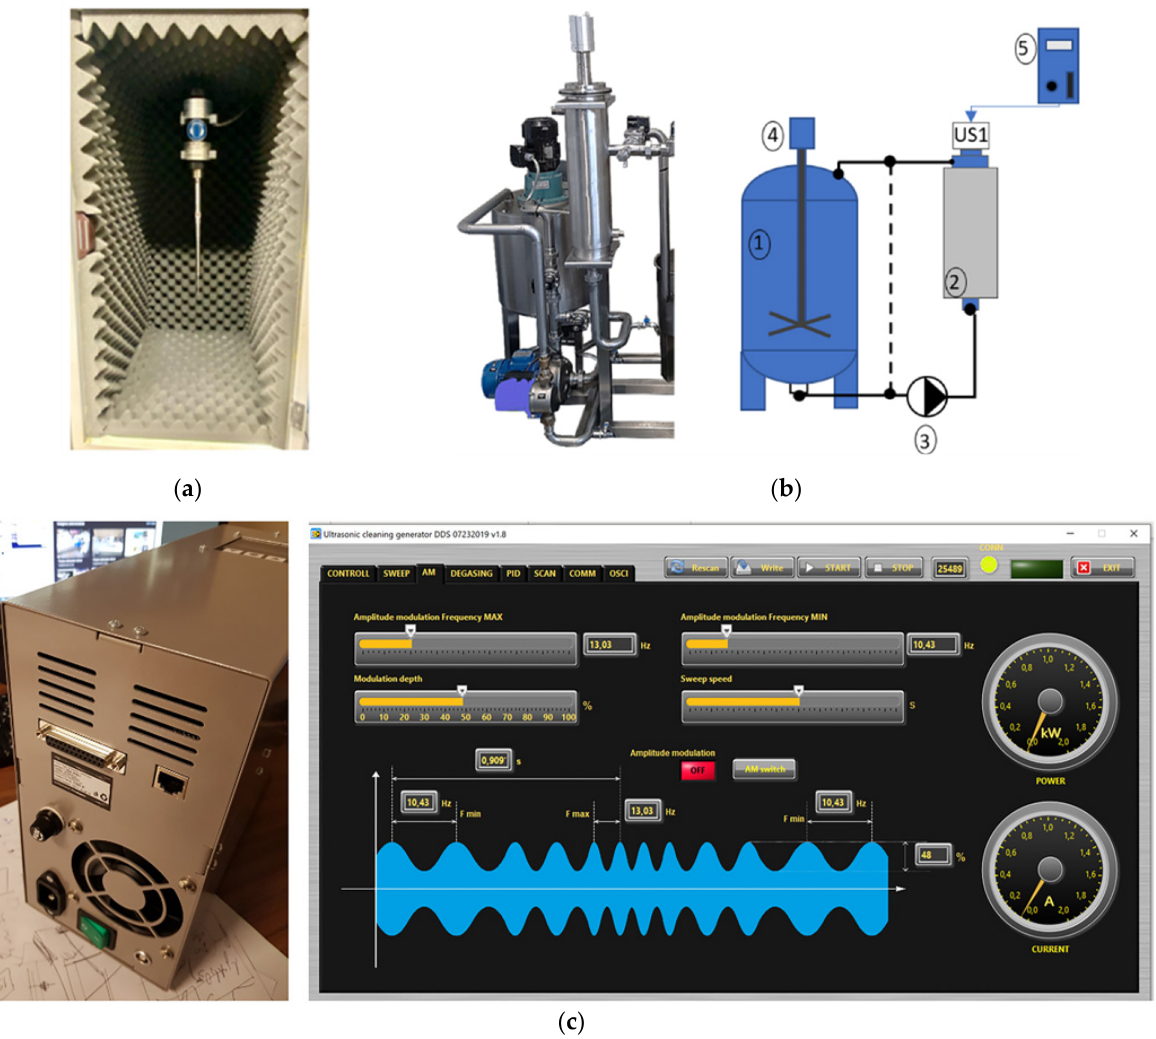
Figure 1. Ultrasonic caffeine extraction: ( a ) Laboratorial scale; ( b ) Pilot scale (1—Tank, 2—Chamber of extraction/homogenization, 3—Pump, 4—Mixer, 5—MMM Generator); ( c ) MPI Generator and software controller.